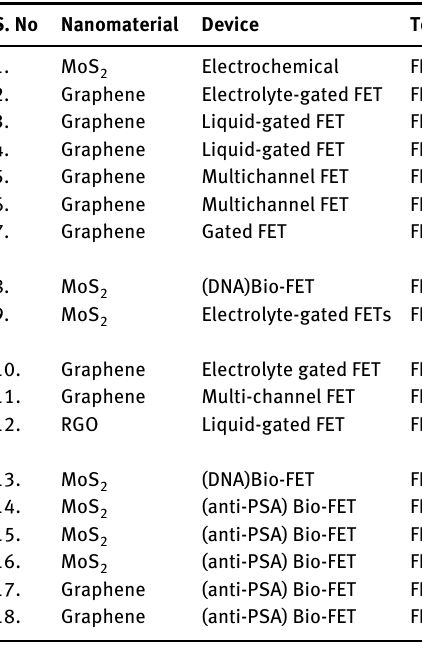
Table 3: 2D nanostructures in electronic devices for